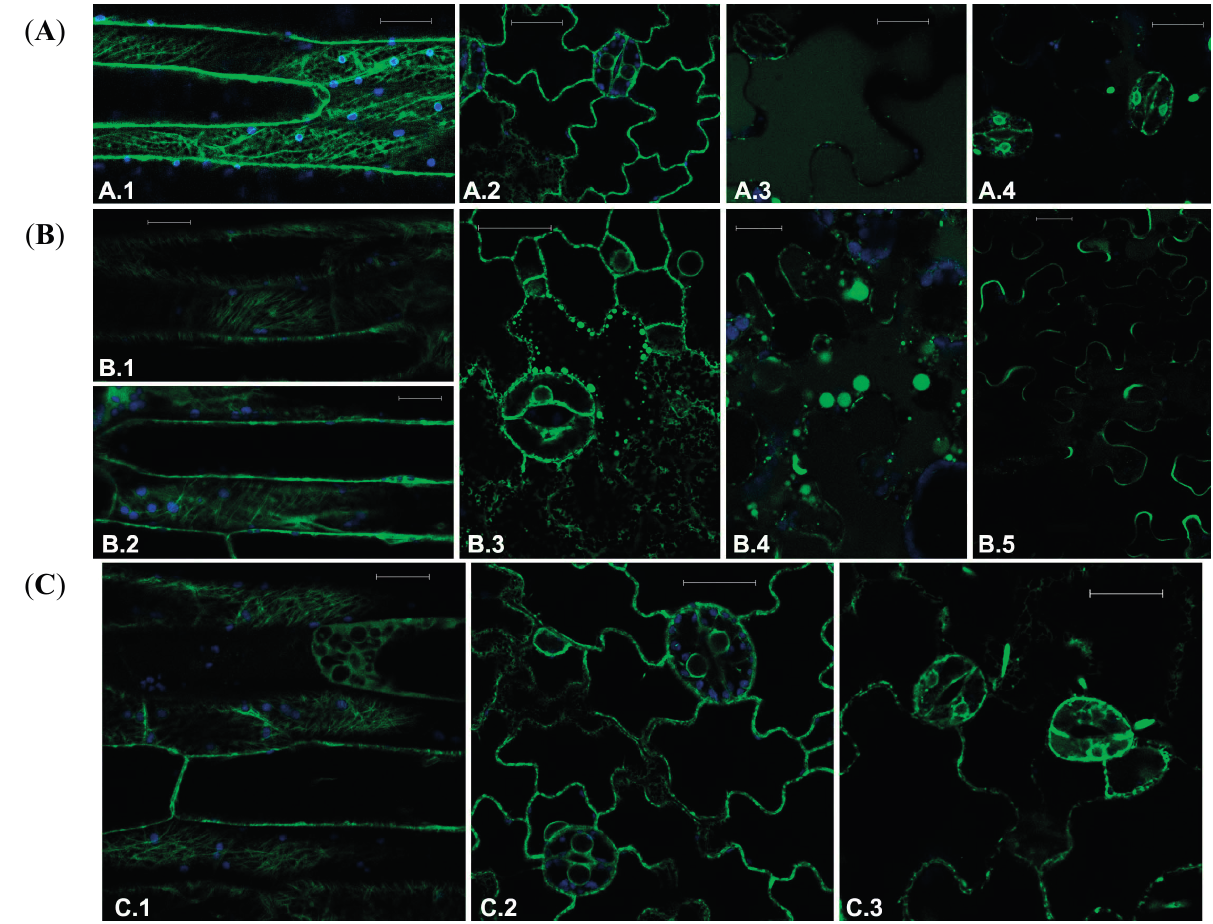
Figure 2. ( A ) Fluorescent patterns of GFP-tagged marker proteins in transgenic Arabidopsis tissues in control conditions ( A.1 ) GFP-TUA6 in petiole cells, ( A.2 ) GFPKDEL, ( A.3 ) AleuGFP, and ( A.4 ) GFPChi in leaf epidermis or treated with drugs targeting the endomembranes; ( B ) Effect of treatment with Crizotinib at the concentration of 0.2 μ M ( B.1 ) or 20 μ M ( B.2 ) on fluorescent pattern of GFP-TUA6 in petiole cells; ( B3 ) effect of 20 μ M in leaf epidermis on GFPKDEL; ( B.4 ) AleuGFP and ( B.5 ) GFPChi distribution; and ( C ) Effect of treatment with Sorafenib at the concentration of ( C.1 ) 2 μ M on GFP-TUA6 in petiole cells or 1 μ M on GFPKDEL ( C.2 ) and AleuGFP ( C.3 ) in leaf epidermis. GFP fluorescence and chlorophyll autofluorescence are shown in green and blue, respectively. Scale bar = 20 μ